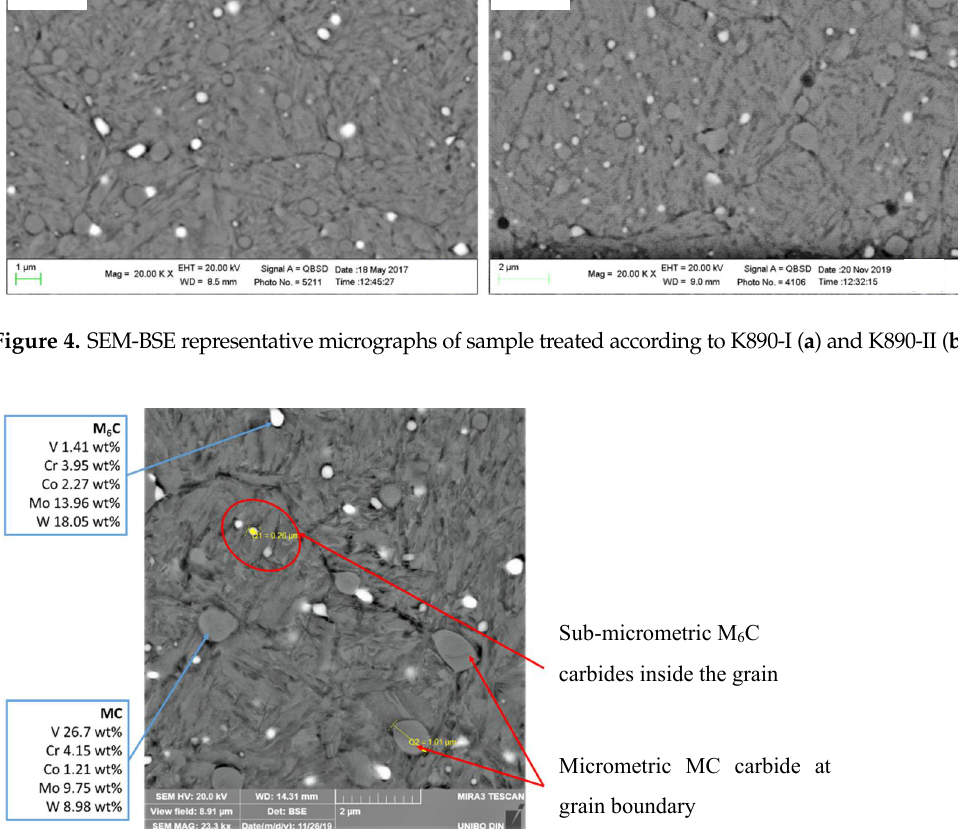
Micrometric MC carbide at